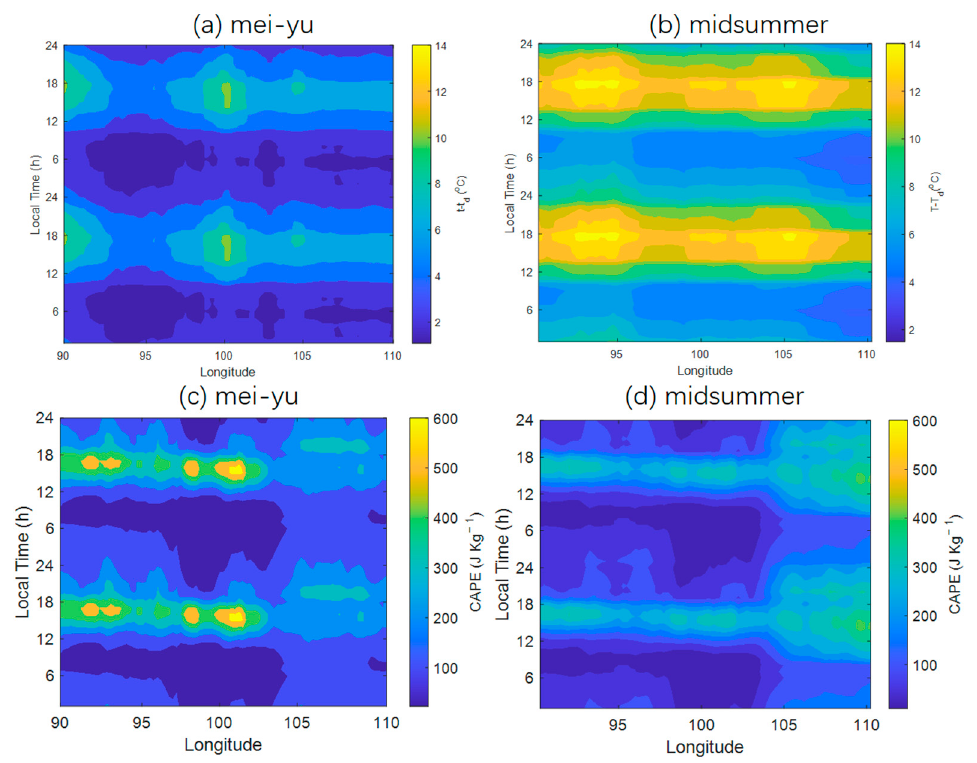
Figure 8. Diurnal variation in ( a , b ) dewpoint spread and ( c , d ) convective available potential energy (CAPE) from ERA5 over the Tibetan Plateau and Sichuan Basin during the ( a , c ) mei-yu and ( b , d ) midsummer periods.